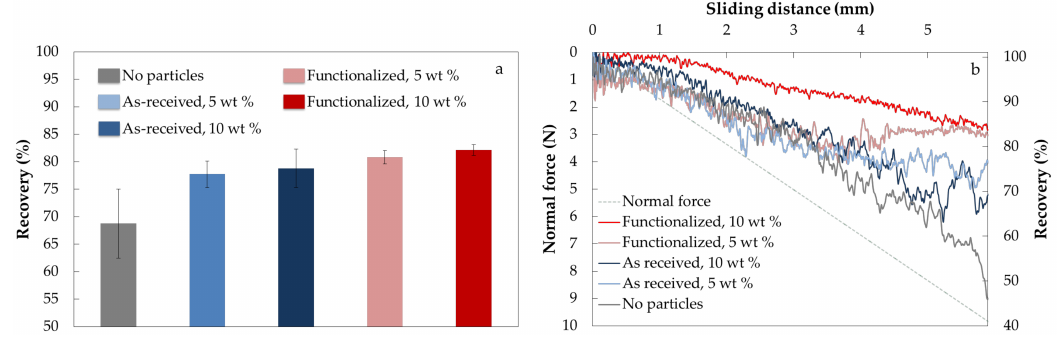
Figure 6. Elastic recovery properties of laminates after micro scratch test with ( a ) a constant load of 10 N, and ( b ) progressive load from 0 to 10 N as a function of sliding distance.